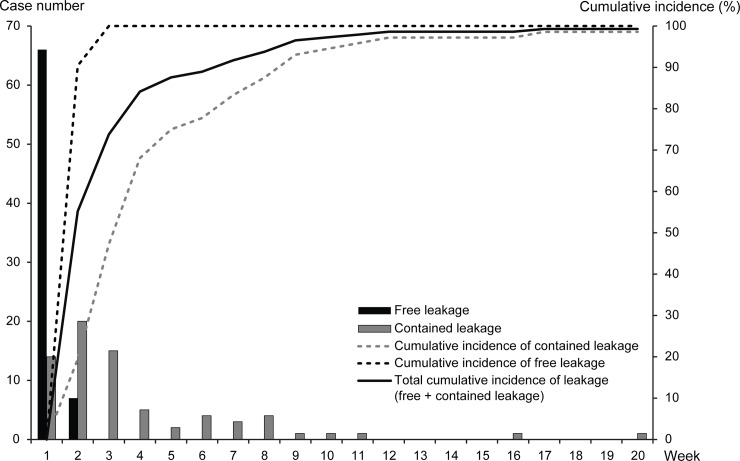
Incidence of anastomotic leakage.